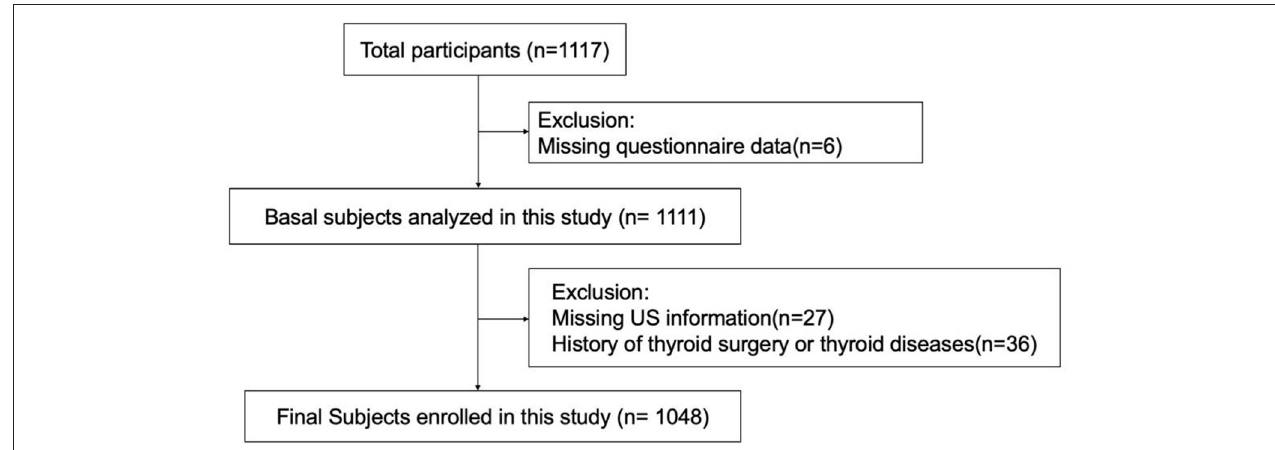
FIGURE 1 | Flowchart of the inclusion and exclusion of